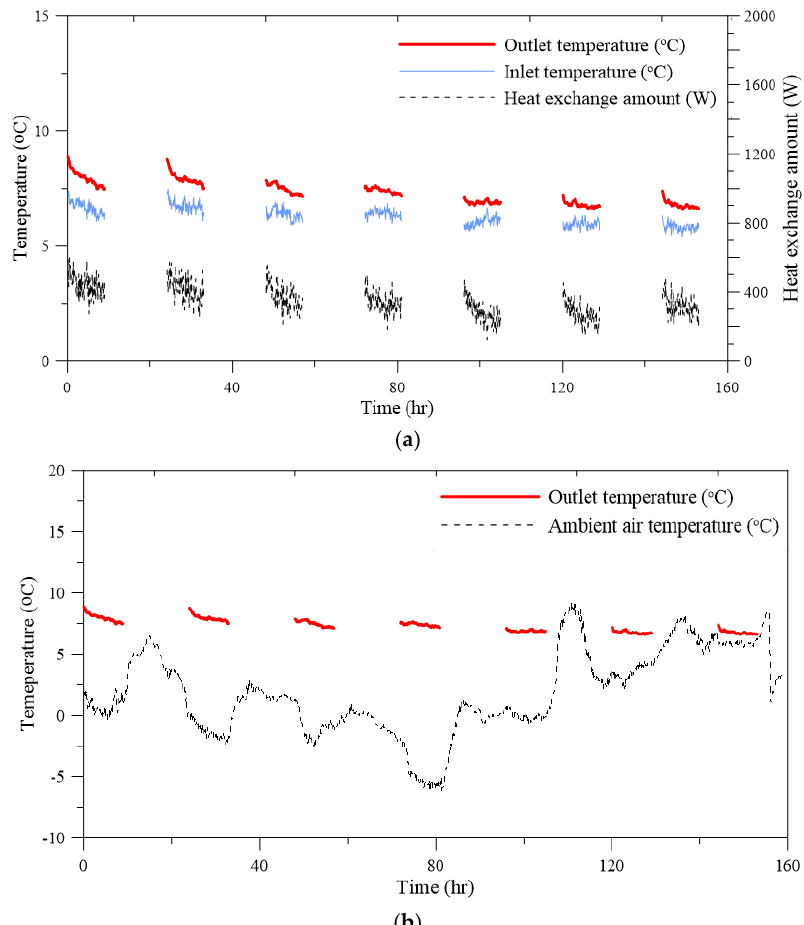
Figure 14. Thermal performance test (TPT) results of floor-type energy slab with stainless steel (STS) pipe (with thermally insulation). ( a ) Inlet, outlet temperature and heat exchange amount; ( b ) Outlet and ambient air